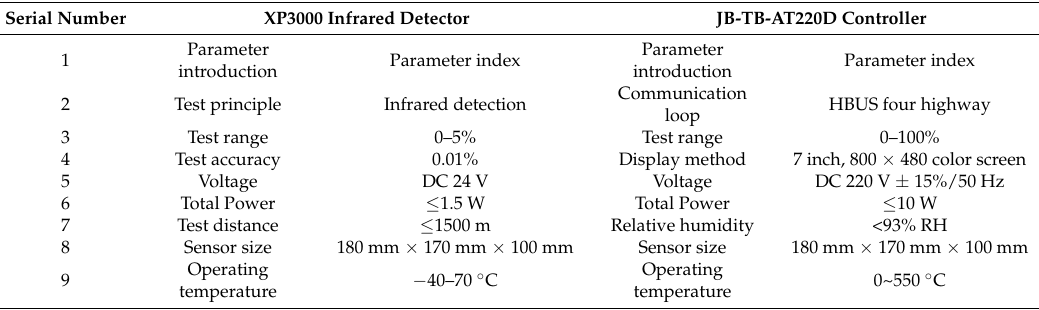
Table 1. Parameter index of XP3000 infrared detector and JB-TB-AT220D Controller.